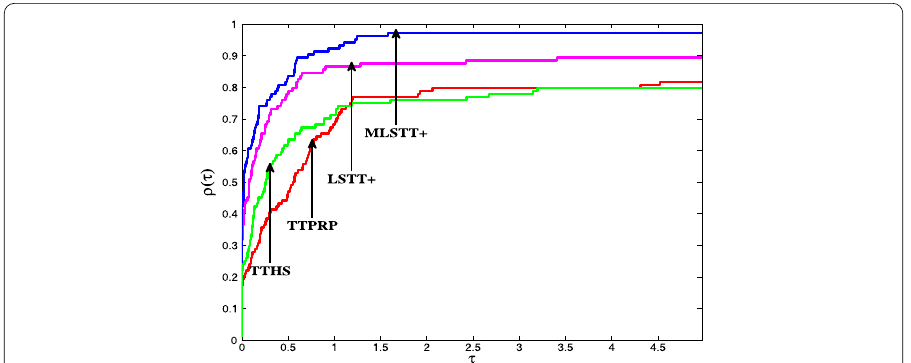
Figure 1 Performance profiles on Itr of four CG methods